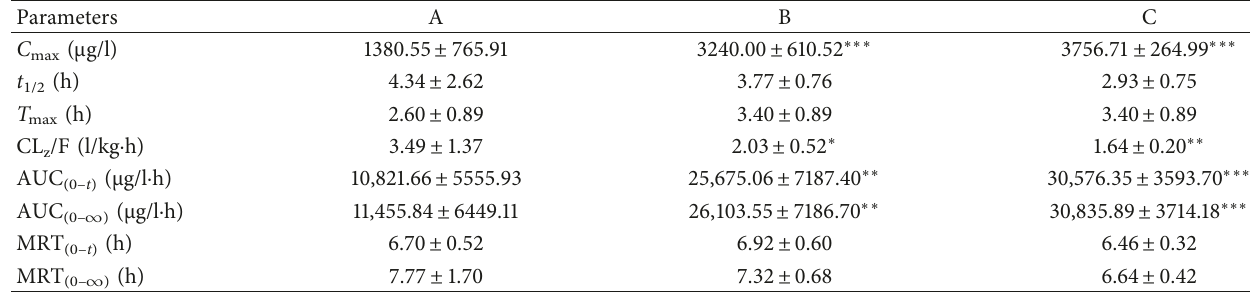
Figure 5: The mean plasma concentration-time curves of celecoxib. Table 1: Main pharmacokinetics of celecoxib in three groups ( n (cid:136)